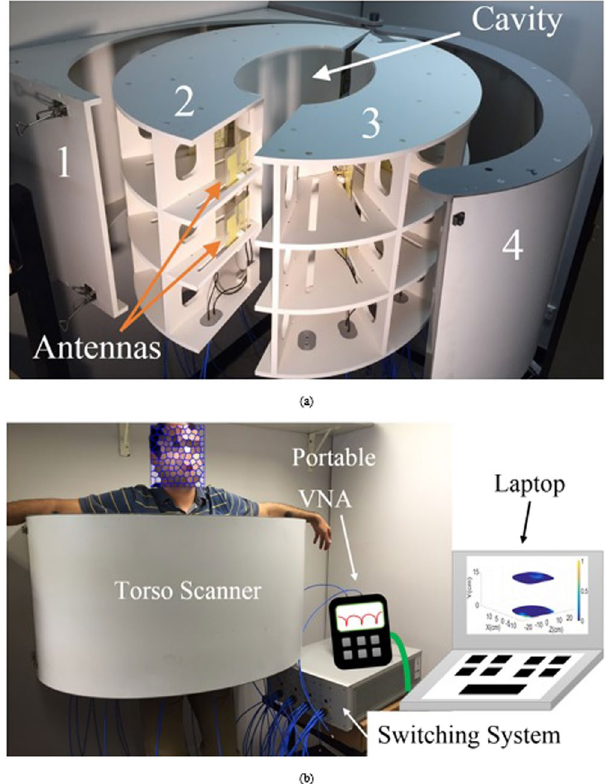
Figure1. ( a ) Dismantled presentation of the proposed torso scanner installed on a wall. ( b ) Measurement setup with human subject inside the